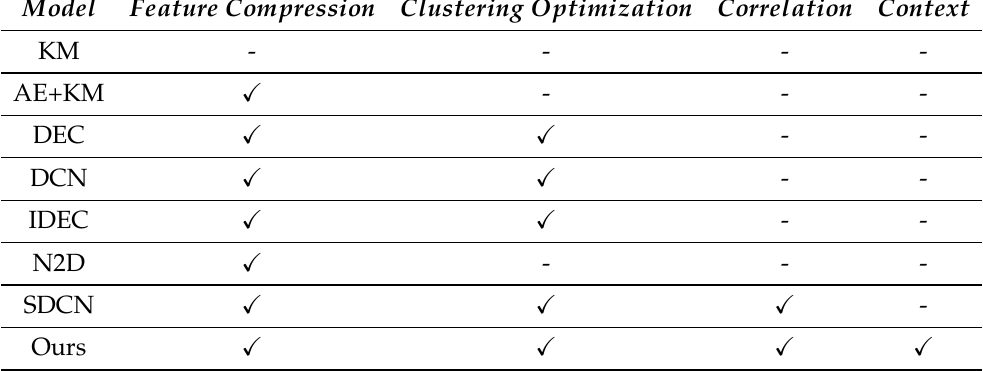
Table 3. Comparison of features of each model.